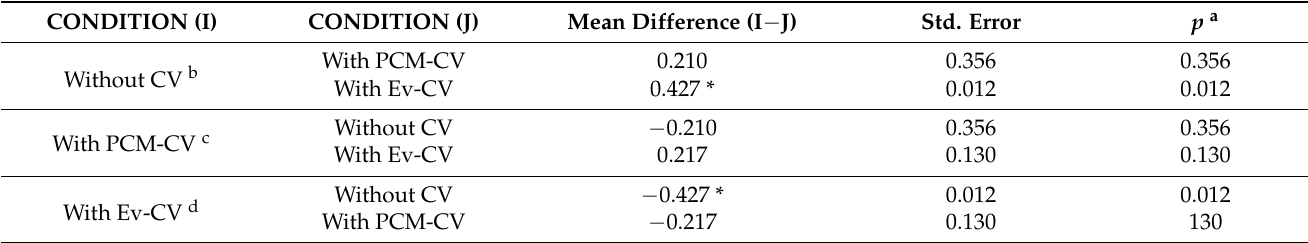
Table 6. Pairwise comparisons for the CONDITION factor. Measurement: